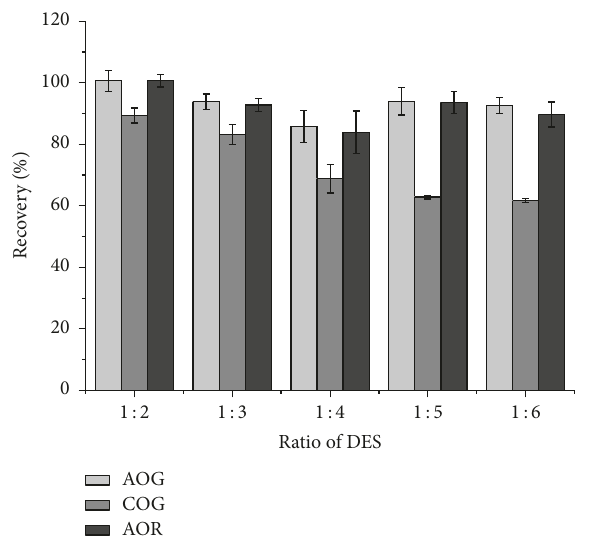
Figure 3: Effect of different solvents on the recoveries of dyes. DES: DES-1-2, sample/liquid: 0.1 g/mL, temperature: 30 ∘ C, time: 20 min, and ultrasonic power: 75 W.